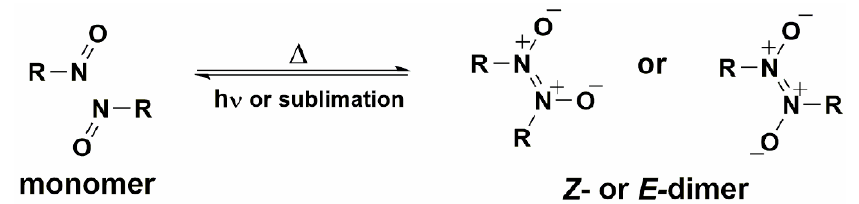
Scheme 1. Dimerization of C-nitroso compounds and dissociation of azodioxy dimers under various conditions.